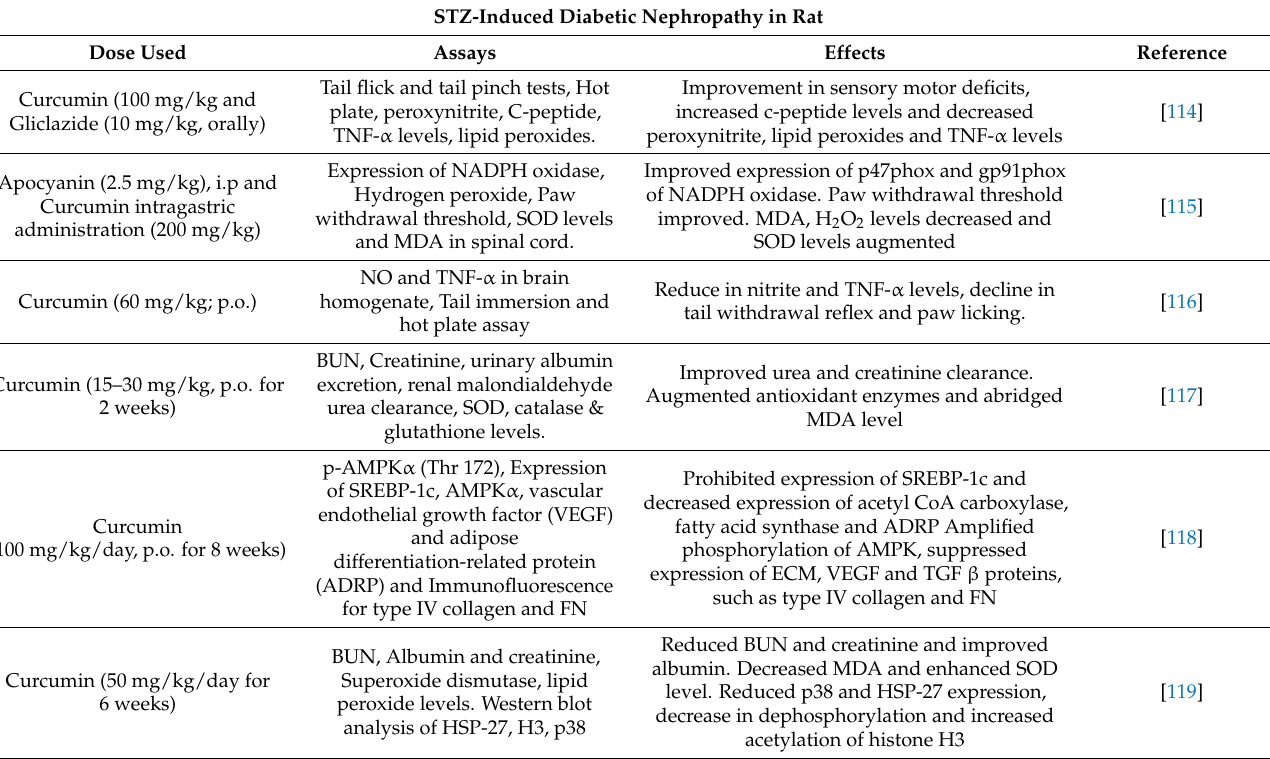
Table 2. Summary of the studies of the effects of curcumin on diabetic complications. STZ-Induced Diabetic Nephropathy in Rat